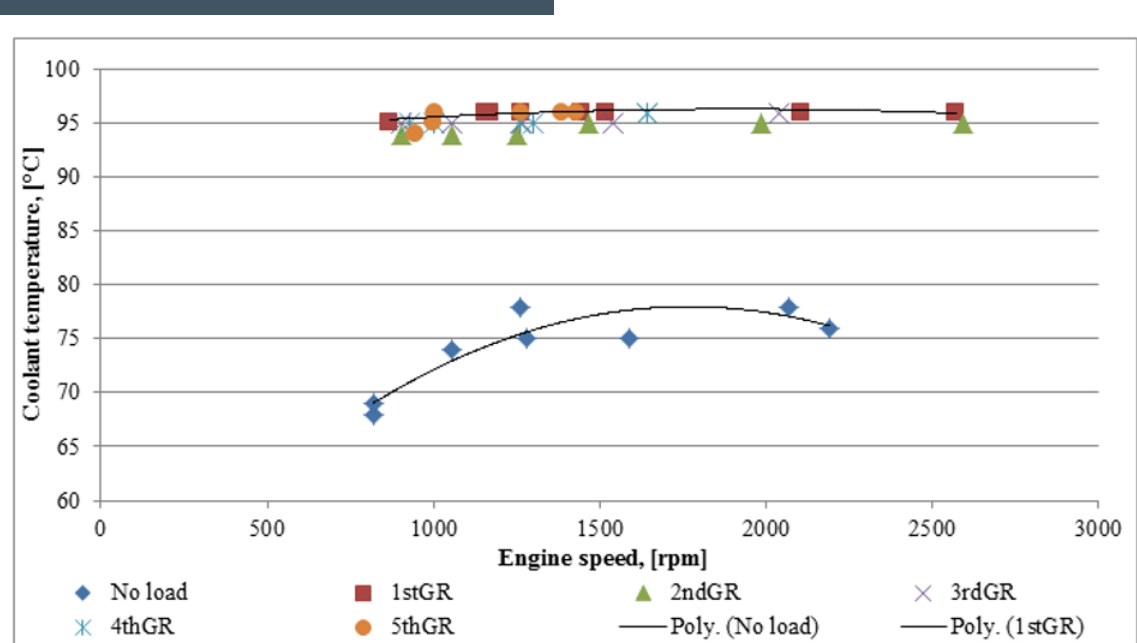
Figure 11. Engine coolant temperature versus engine speed for different gear ratios.